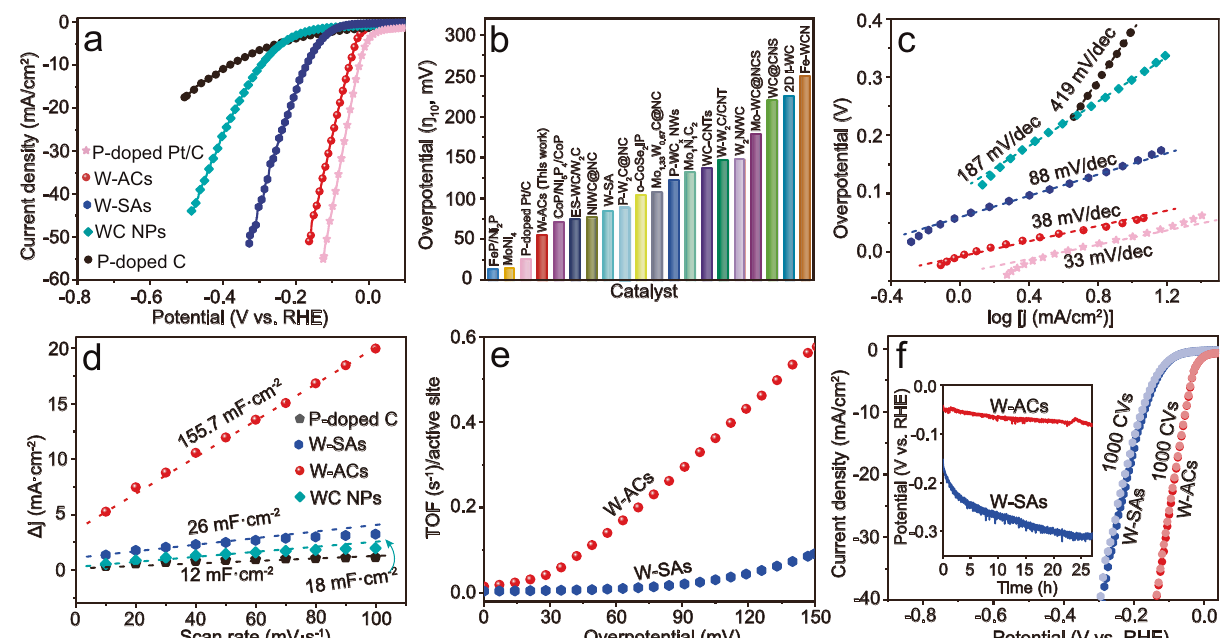
Fig. 3 Evaluation of the alkaline HER performance using W-ACs in 1 M KOH solution. a Polarization (LSV) curves and ( c ) Tafel plots for P-doped C, WC NPs, W-SAs, W-ACs, P-doped Pt/C catalysts. b The overpotentials at 10 mA/cm 2 extracted from W-ACs and P-doped Pt/C catalysts in this work, in comparison with those of non-noble metal catalysts previously reported in alkaline media 3,6,10,16,23,32 – 44 . d Electrochemical double-layer capacitance (C dI ) obtained from CV measurements between – 0.8 and – 0.6 V (vs. Ag/AgCl) at different scan rates (100 – 10 mV/s) for P-doped C, WC NPs, W-SAs and W-ACs. e TOF curves of W-SAs, and W-ACs. f LSV curves for W-SAs and W-ACs before and after 1000CVs, with the chronopotentiometry measurements at current density of 10 mA/cm 2 in the Figs. 19, 20). The linear sweep voltammetry (LSV) curves for all catalysts were presented in Fig. 3a, and all potentials measured